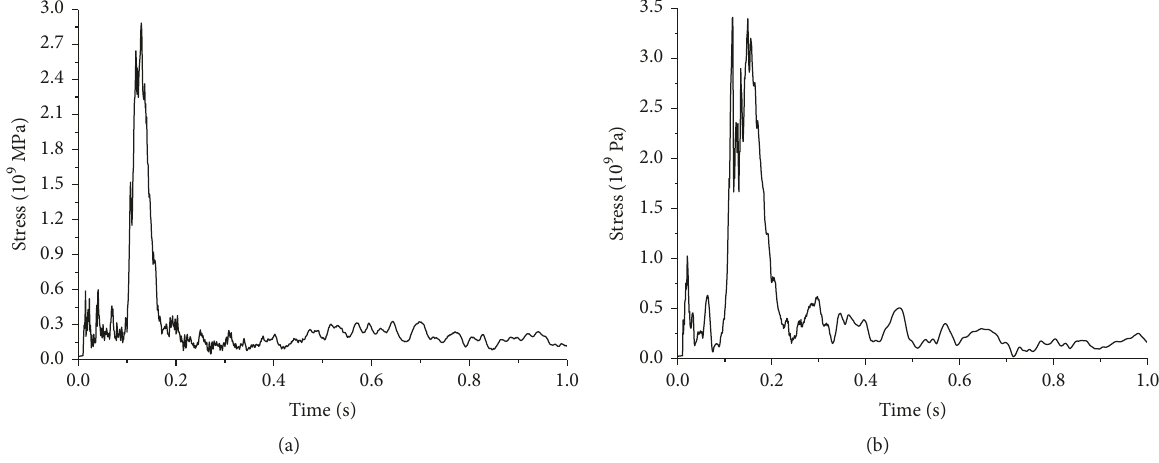
Figure 25: Stress time history curves of the maximum stress element in the two models: (a) model 10 and (b) model